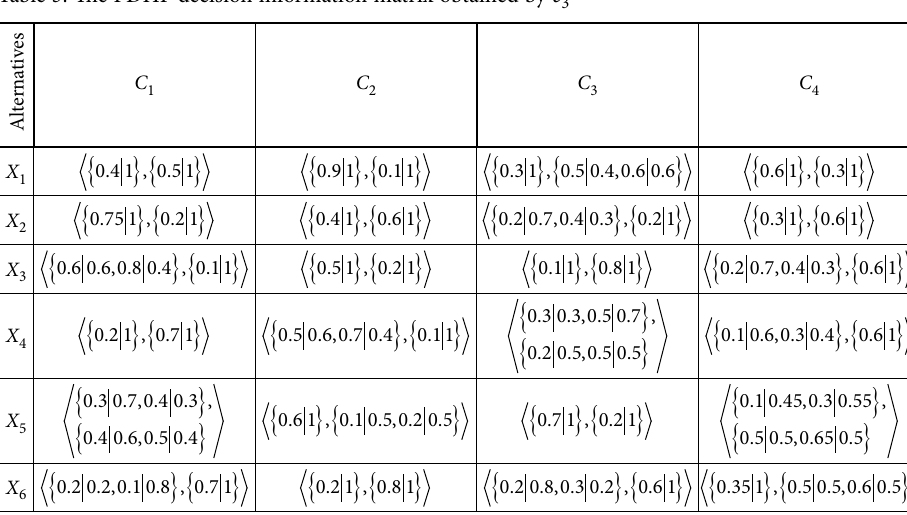
0.3 0.7,0.4 0.3